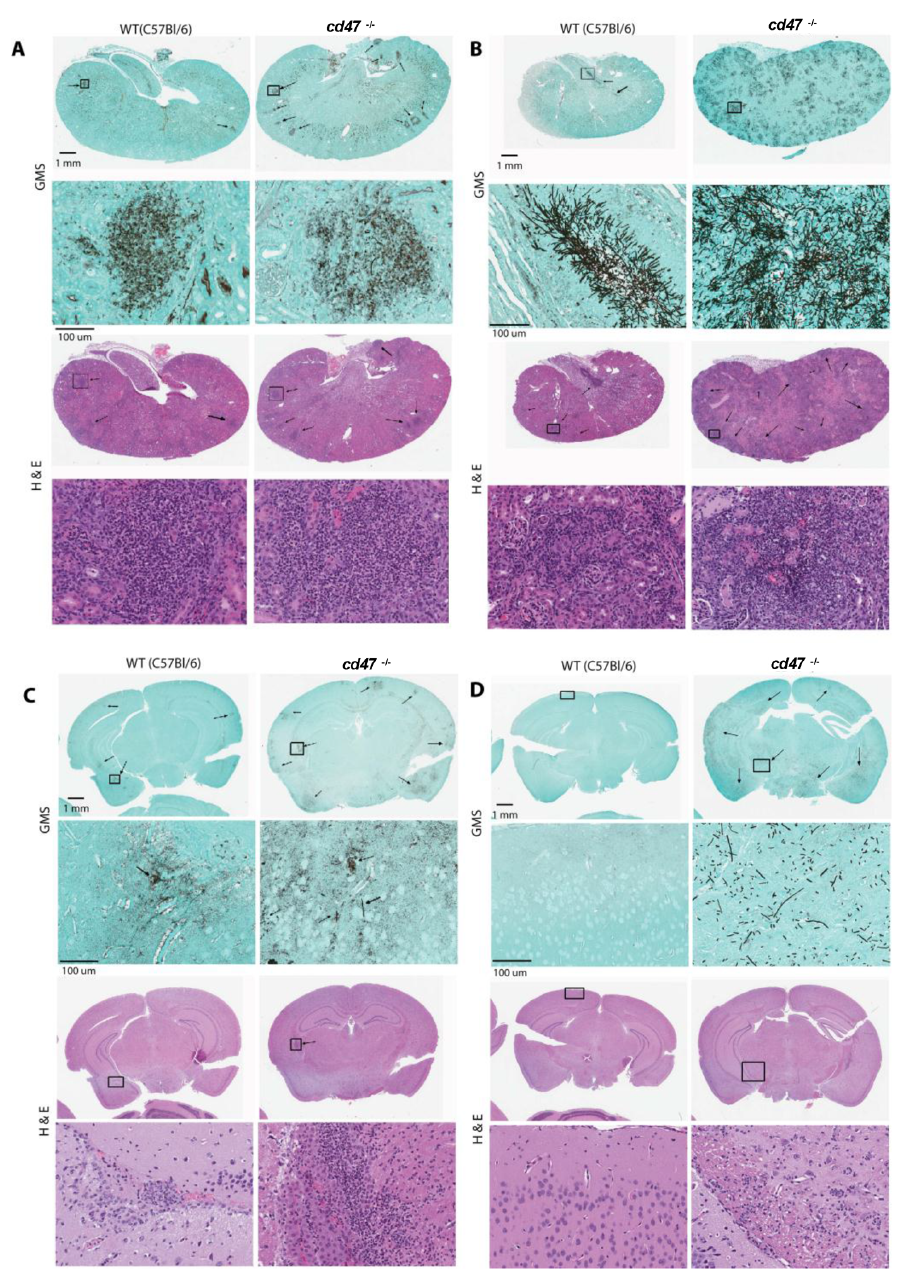
Fig 2. Kidneys and brains of cd47 -/- mice infected with C . albicans show increased fungal colonization and inflammatory responses. (A & C) Representative GMS-stained sections of mouse kidney and brain tissue to detect C . albicans colonization (black) and H&E stained sections to show inflammatory reactions in cd47 -/- kidneys compared with the WT at day 2 PI. (B & D) Comparative histopathology of mice with disseminated candidiasis at 4 days PI. Kidney and brain tissues were stained using GMS to detect C . albicans colonization (black) and H&E to assess inflammatory reactions. cd47 -/- kidneys showed higher fungal colonization and more inflammation. cd47 -/- brains showed higher fungal colonization at both time